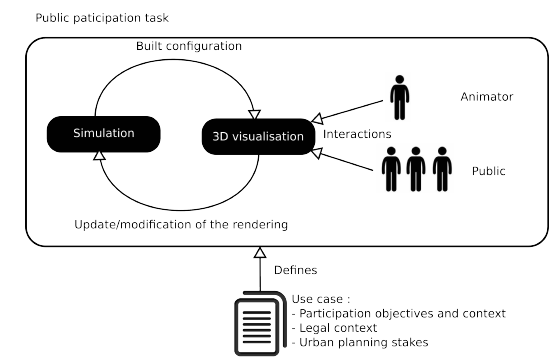
Figure 1. The considered global participation process and the system presented in this